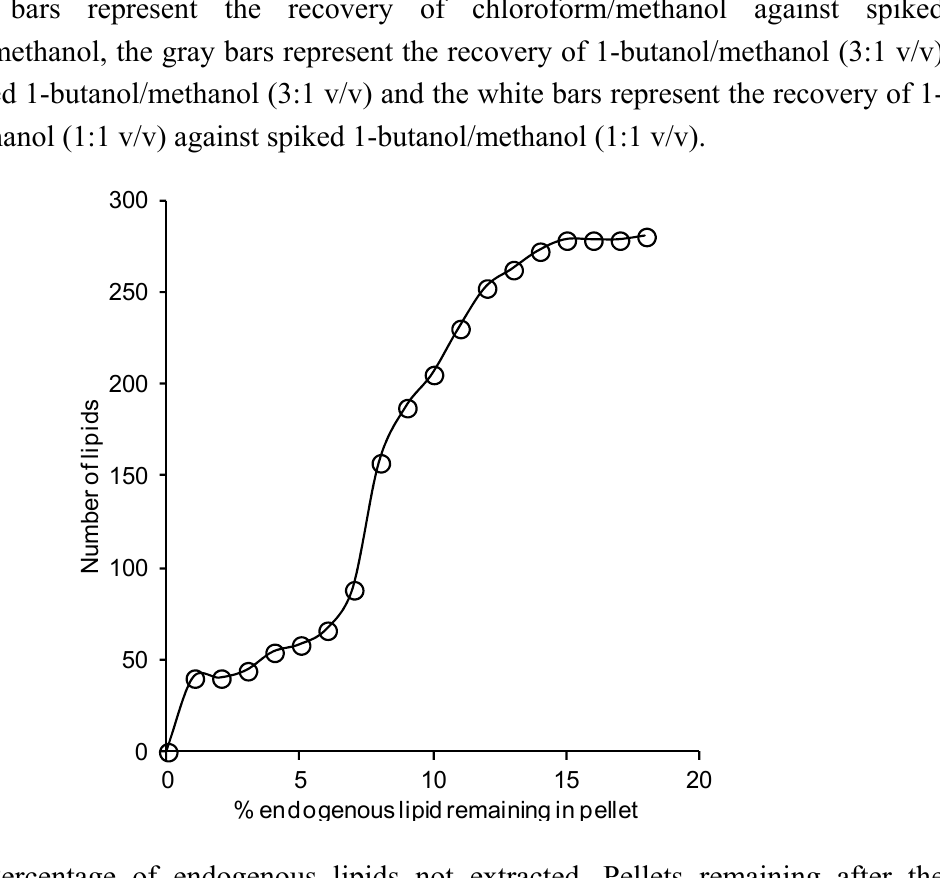
Figure 2. Percentage of endogenous lipids not extracted. Pellets remaining after the initial extraction ( n = 3) were re-extracted and the lipids quantified. The re-extracted lipids were expressed as a percentage of the total lipids extracted in the first and second extractions